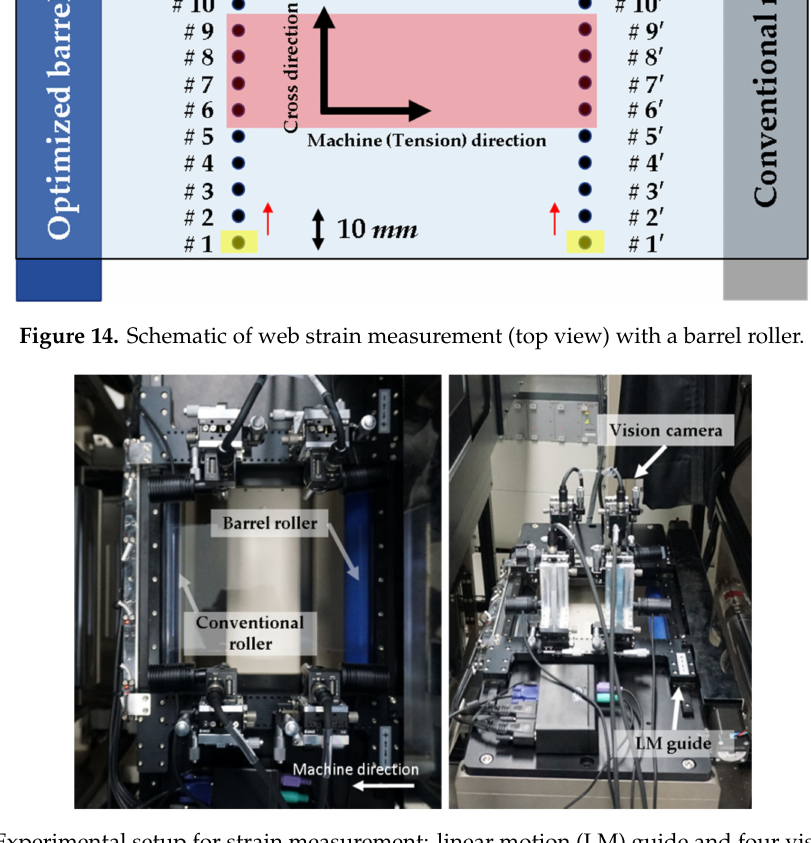
Figure 15. Experimental setup for strain measurement: linear motion (LM) guide and four vision